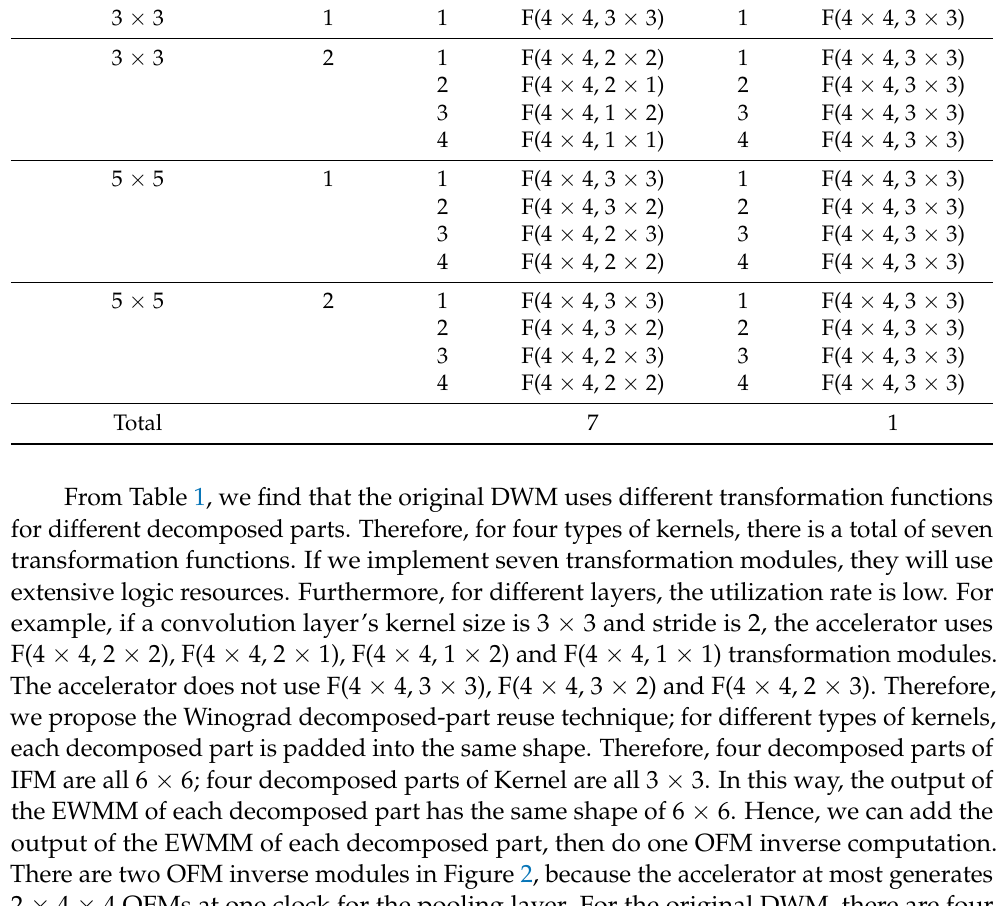
Table 1. Transformation function of DWM and WDPR under four types of kernels. Kernel Size (K ×